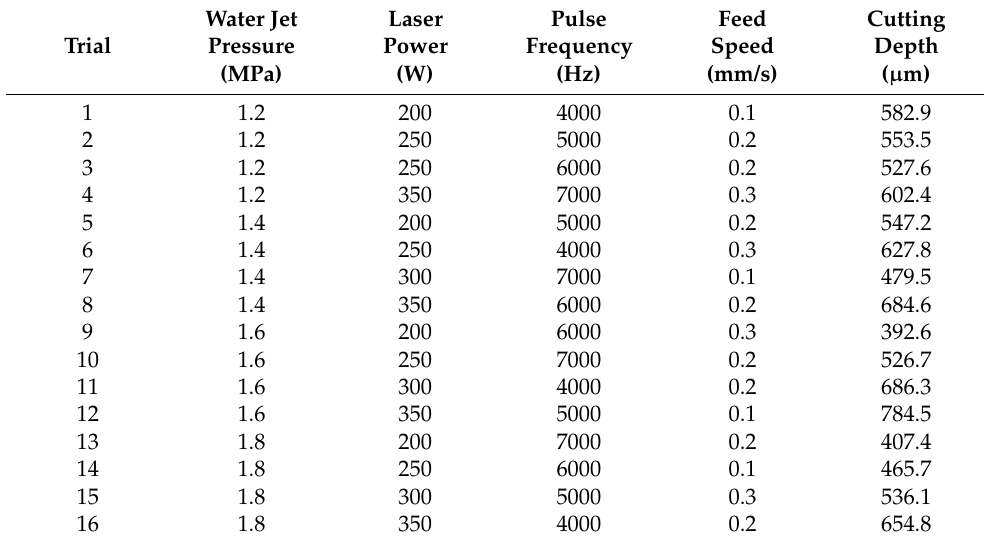
Table 4. Taguchi orthogonal experimental dataset.